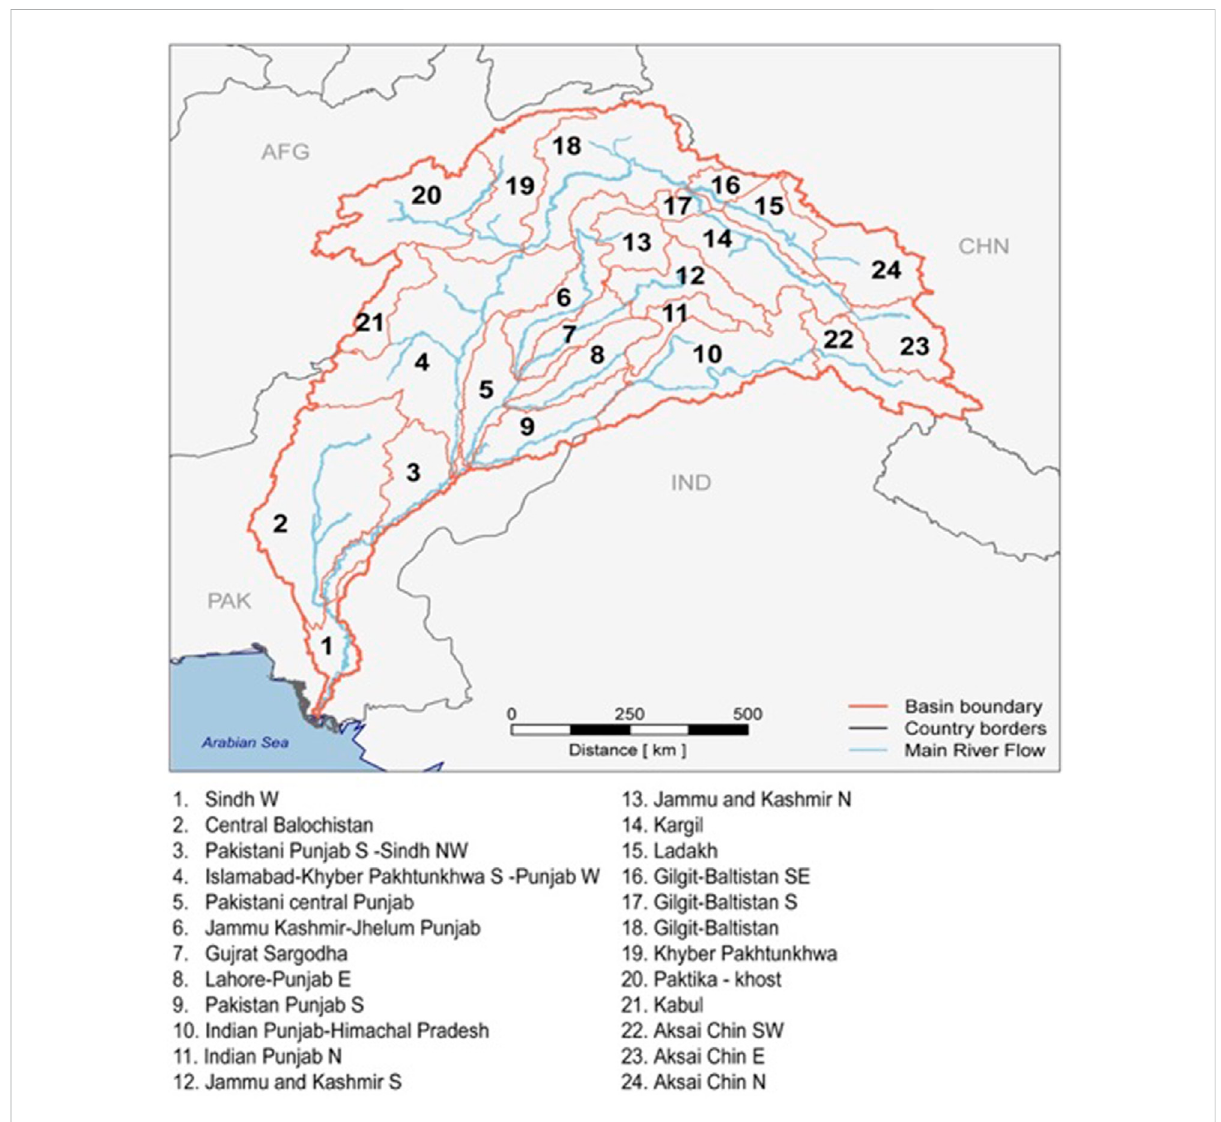
FIGURE 1 Spatial delineation of the IRB in the modeling